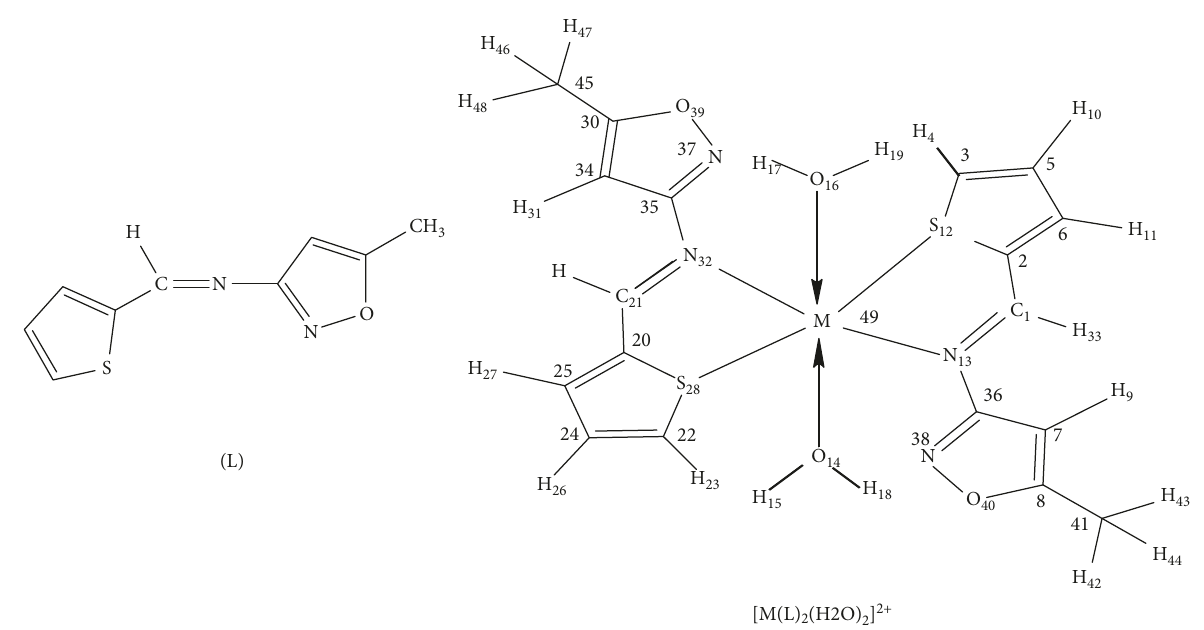
Figure 1: Structure of ligand (L) and metal complexes where M